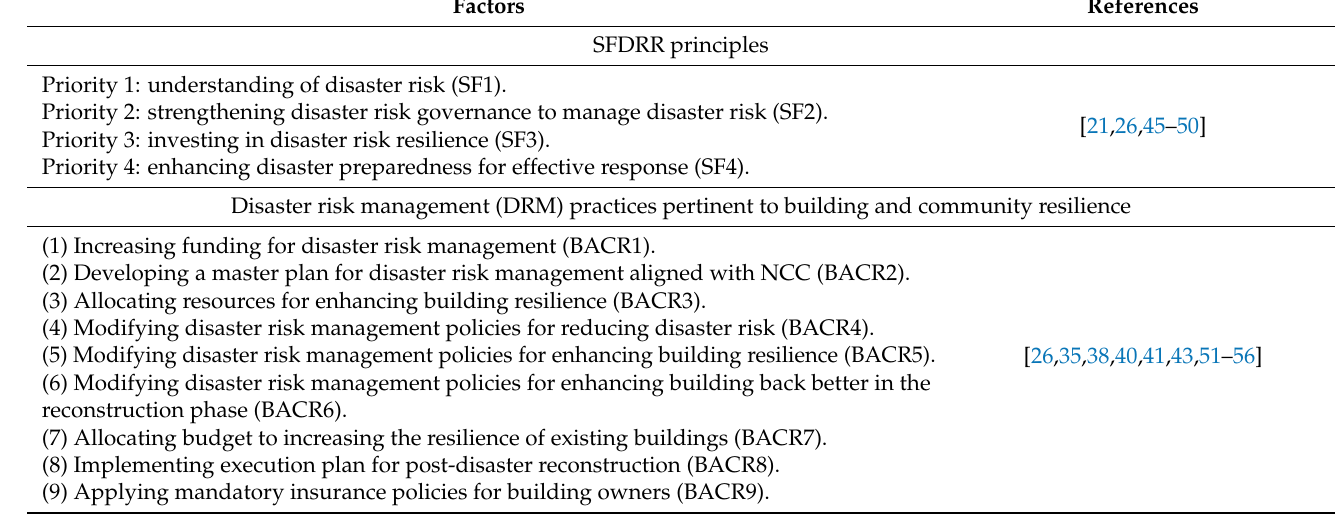
Table 1. SFDRR principles and DRM practices pertinent to building and community resilience.